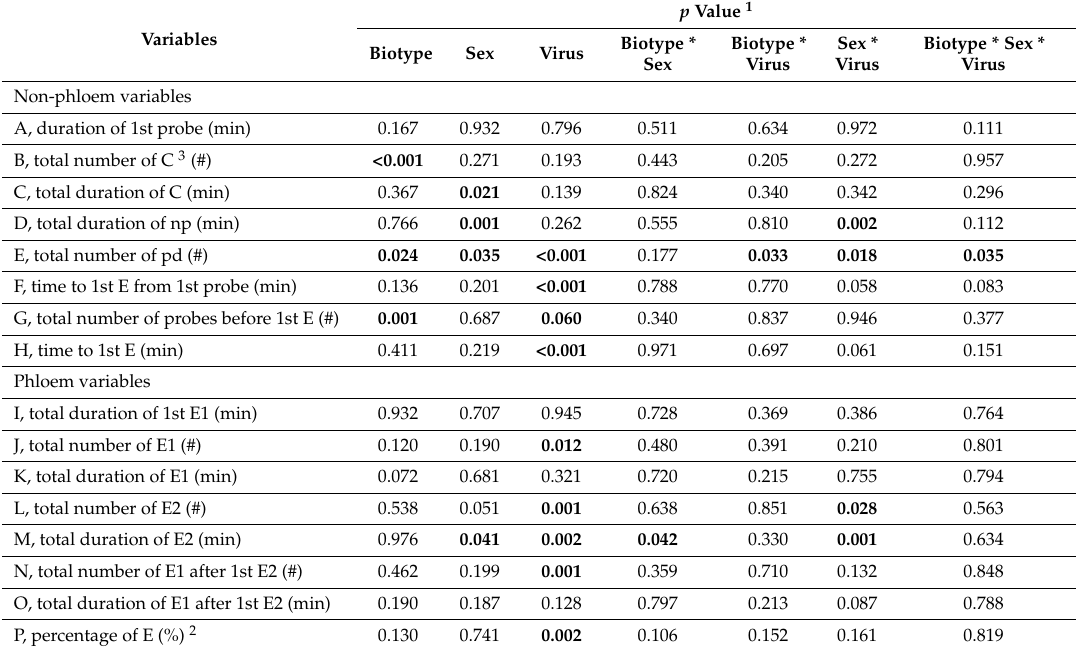
Table 4. Interaction analysis of EPG variables among sexes, viruliferous status and biotypes of B. tabaci by multivariate